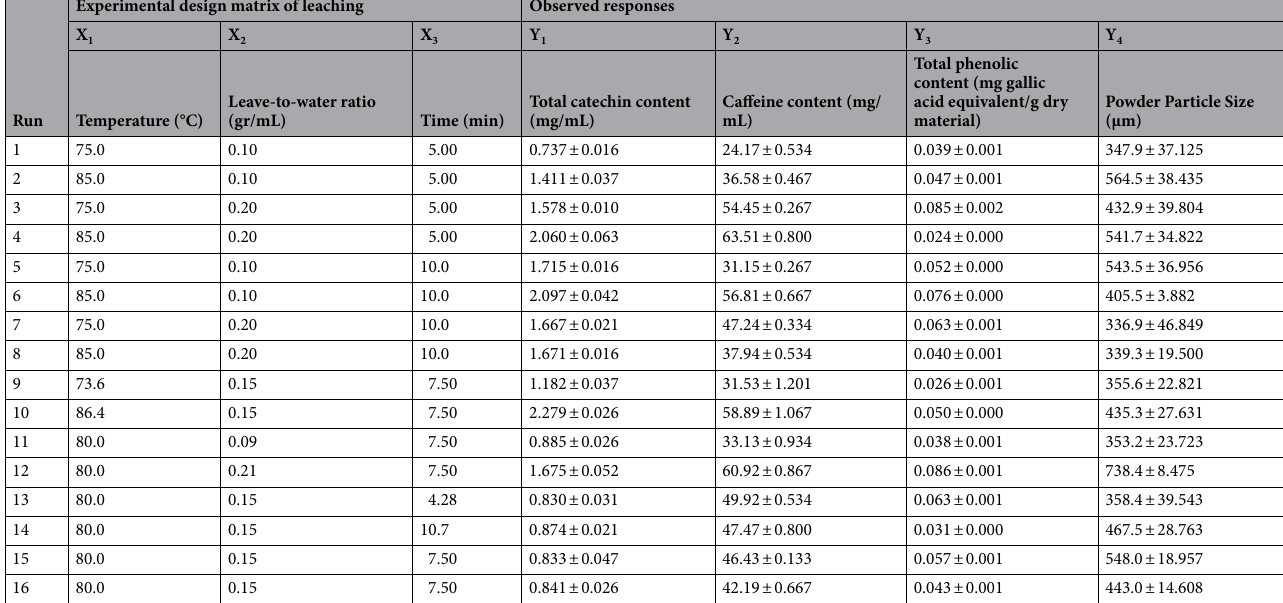
Table 2. Experimental design matrix of leaching and observed responses of spray-dried powder of extract bancha green